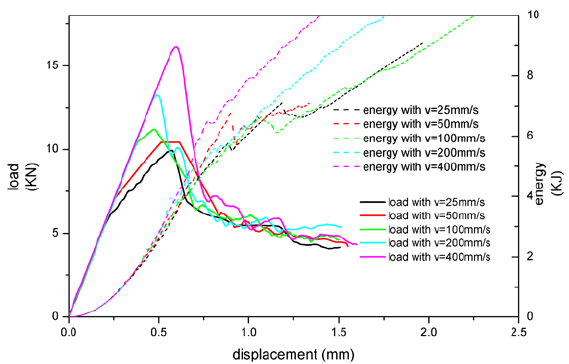
Figure 6. The relationship between load, energy absorption, and displacement with tiebreak contact. When the adhesive material was stimulated with tiebreak contact, the trend of load-displacement curve was basically the same as that of MAT 185. As the velocity increased, the peak load increased, and the peak value became more abrupt. When the velocity was small, the peak load remained unchanged for a period of displacement from buckling to adhesive failure as shown in Figure 6. In terms of energy absorption, the curve presented multilinearity, and the absorbed energy decreased first and then increased as the velocity was increased. As shown in Figure 7, the peak load values of the two modeling methods were obviously different. The peak load of MAT 185 was larger than tiebreak contact, and the residual load after the adhesive layer fails was also larger than tiebreak contact. For the changing of load rate, MAT 185 was more sensitive and the critical loads change more obvious. In terms of the energy absorption, the energy lines of MAT 185 tended to a straight curve, while that of tiebreak contact was multilinear. In addition, the amount of energy absorption varied with responses to the velocity. The main reason for these differences lied in the different sandwich plate failure modes presented by the two models.